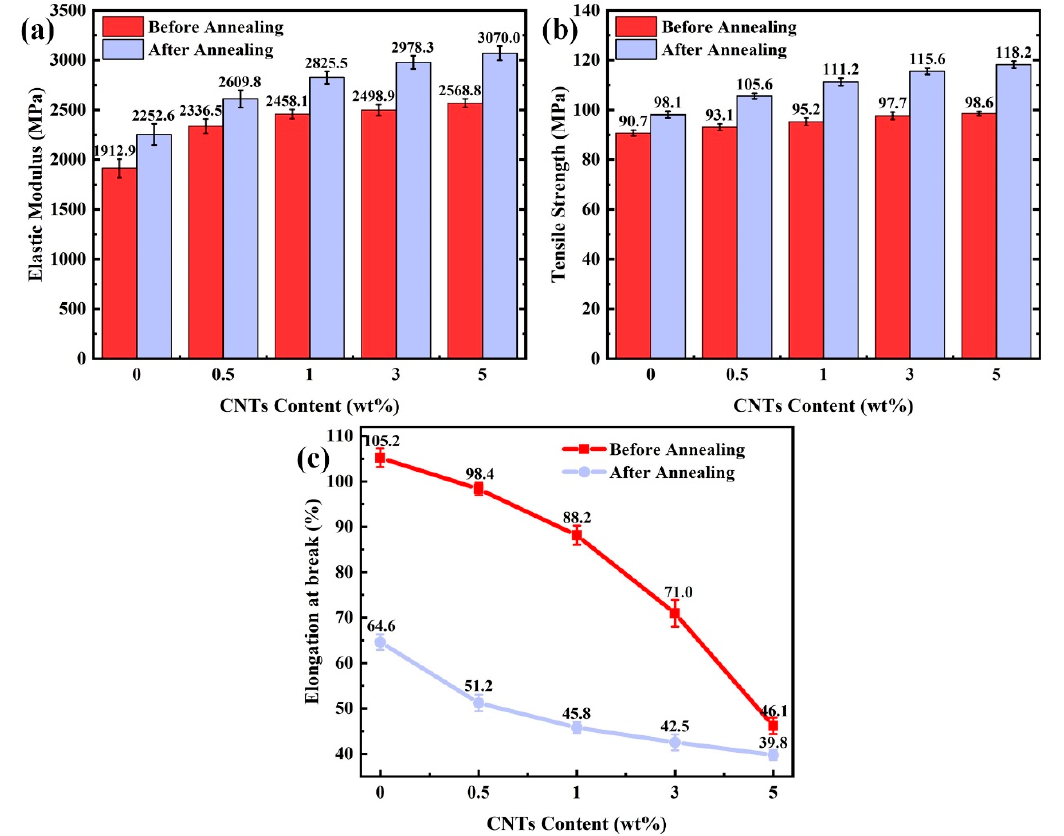
Figure 7. Mechanical properties of PEEK/CNT composites with different CNT content: ( a ) tensile strength; ( b ) elastic modulus; ( c ) elongation at break.